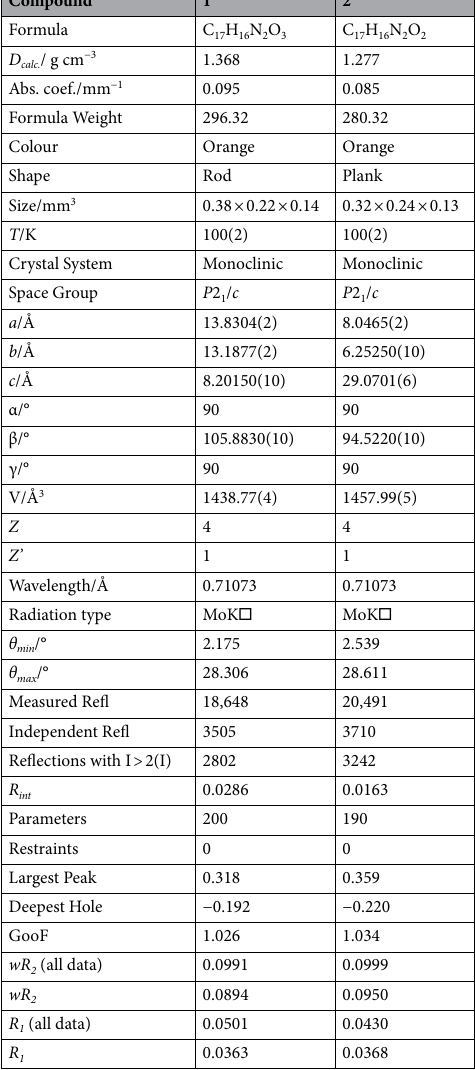
Table 1. Crystallographic data of the Schiff base compounds.